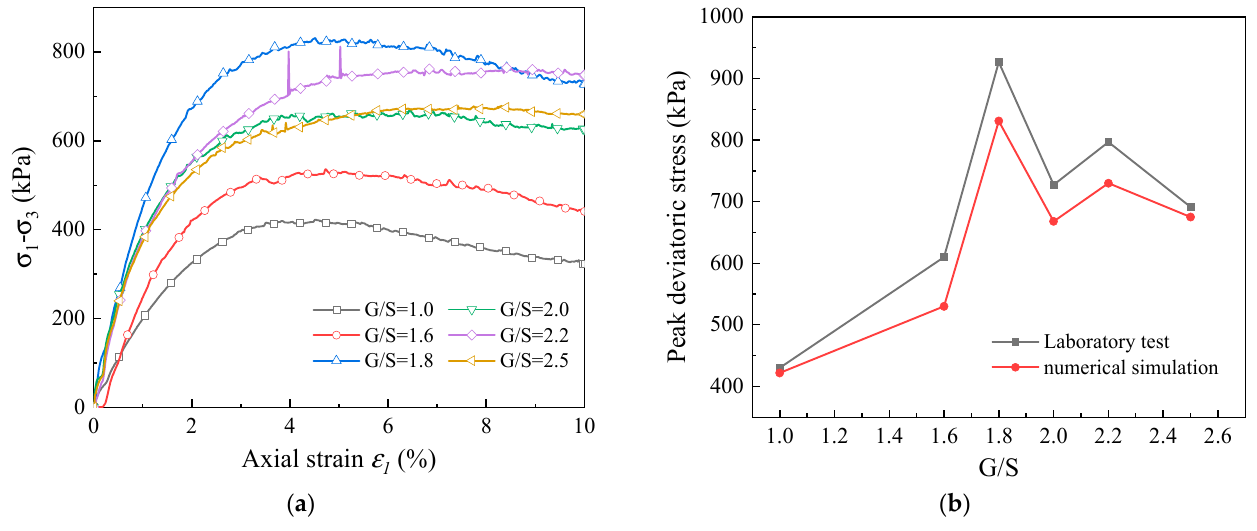
Figure 12. DEM-simulated results of monotonic triaxial compression tests: ( a ) deviator stress versus axial strain curves for different G/S levels and ( b ) comparison of lab-measured and model-simulated peak deviator stress for different G/S values.